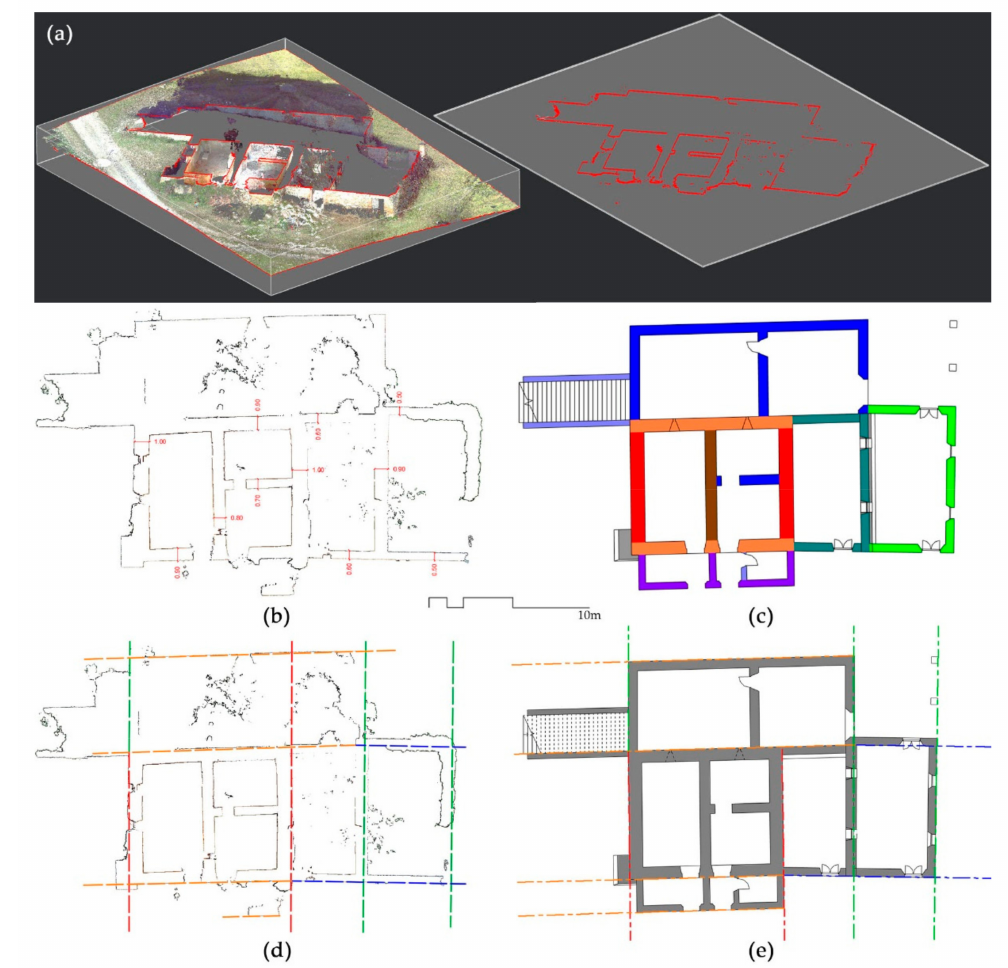
Figure 5. ( a ) Segmentation process of the point cloud into slices in order to extract two-dimensional information, ( b , d ) one of the slices on which the thicknesses and alignments were analyzed respec- tively; ( c ) thematic plan view of the BIM model in which a color os associated with the wall parameter “thickness” for each value derived from the survey; this process highlights the building partitions with similar characteristics. ( e ) Plain view of the BIM model in which the alignments deduced from the cloud analysis are not a parameter of the element but the guideline on which it is